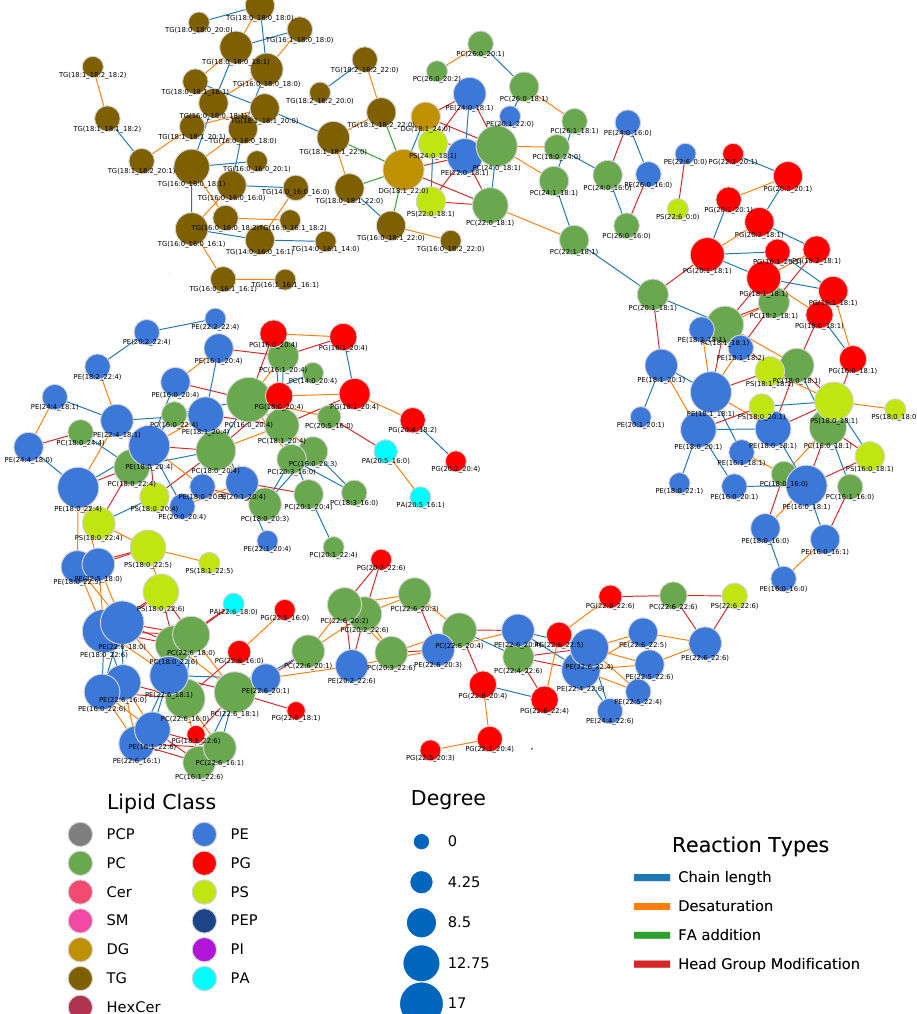
Figure 3. Part of the lipid network of the lipidomics data from Tu et al. [19]. Shown are the two main components of the GPL metabolism. Nodes are colored by lipid class, and edges are colored by reaction type. Node sizes represent the